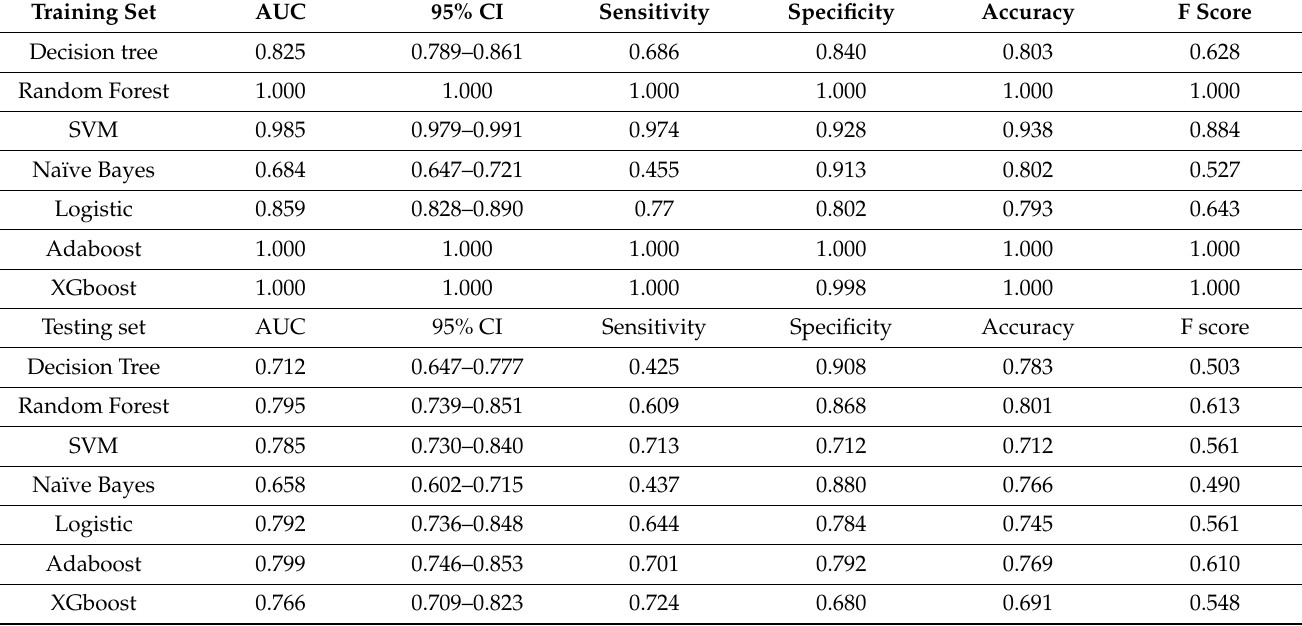
Figure 3. ( a ) The importance of the top 20 features in the Adaboost model; and ( b ) the importance of the top 20 features in the Random Forest model. Table 2. Performance of machine learning algorithms for predicting 30-day mortality in the training set and the testing